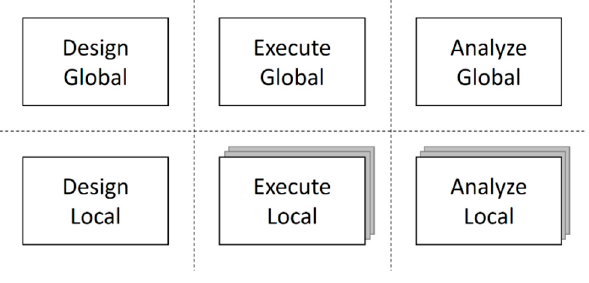
Figure 6. Top-level functionality overview of SHOP4CF [37].